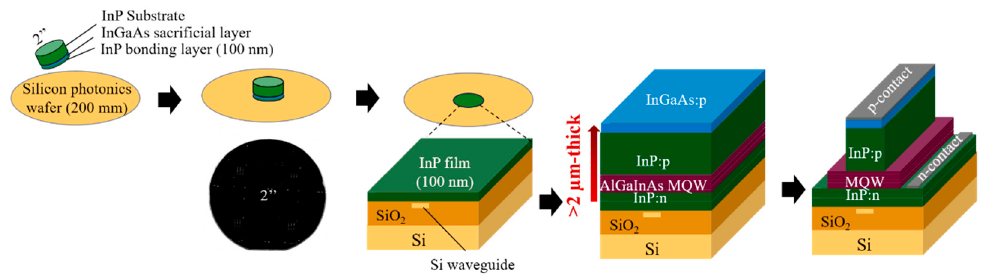
Figure 1. Fabrication process for a vertical laser structure on InP-on-SOI platform with an insert acoustic image of the 2 inch InP/InGaAs/InP(substrate) bonded on a 200 mm SOI